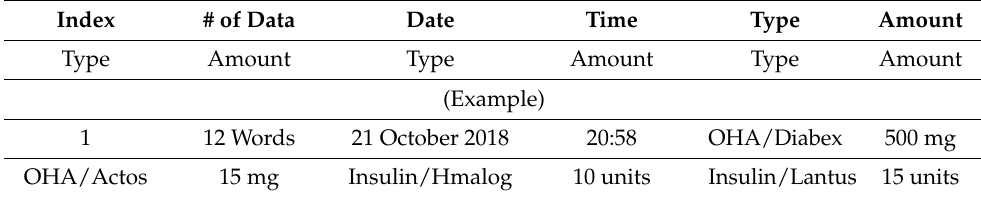
Table 6. The obtained dosage information from the proposed dosage information